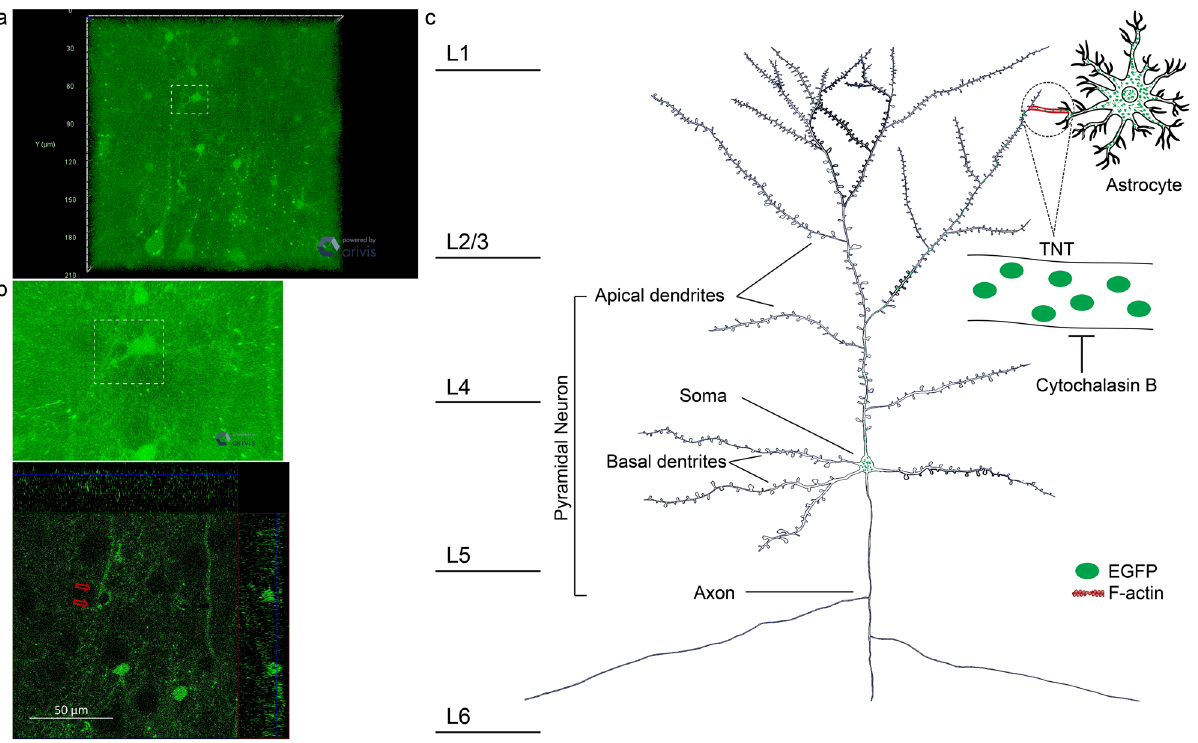
Figure 6. Illustration of the working model for EGFP transportation from astrocytes to neurons in cerebral cortex. ( a ) Detection of the contact connection between an apical dendrite and an astrocyte process by confocal microscopy. ( b ) High magnified stereophotograph (above) and 2D image (below) of the contact connection. ( c ) Schematic illustration: Astrocytes in layer I–III express EGFP. Pyramidal neurons in layer V stretch out apical dendrites to layer I–III with branches close to EGFP expressing astrocytes. With the assistance of F-actin which is enriched in sprouting dendrite branches, pyramidal neurons develop tunneling nano-tubules to astrocytes. EGFP disseminates from astrocytes to neurons through the tunneling nano-tubule. Red arrows, TNT. TNT, tunneling